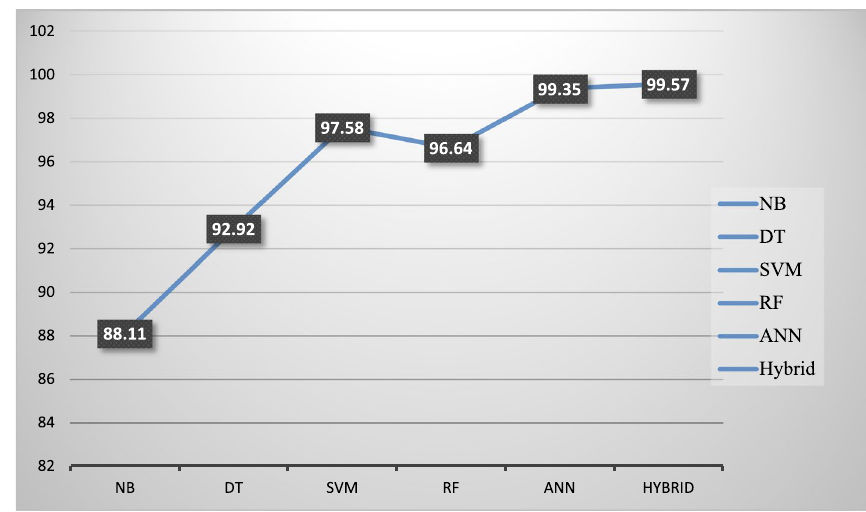
Fig. 5 Performance distribution of the techniques in the training set (f1-score)